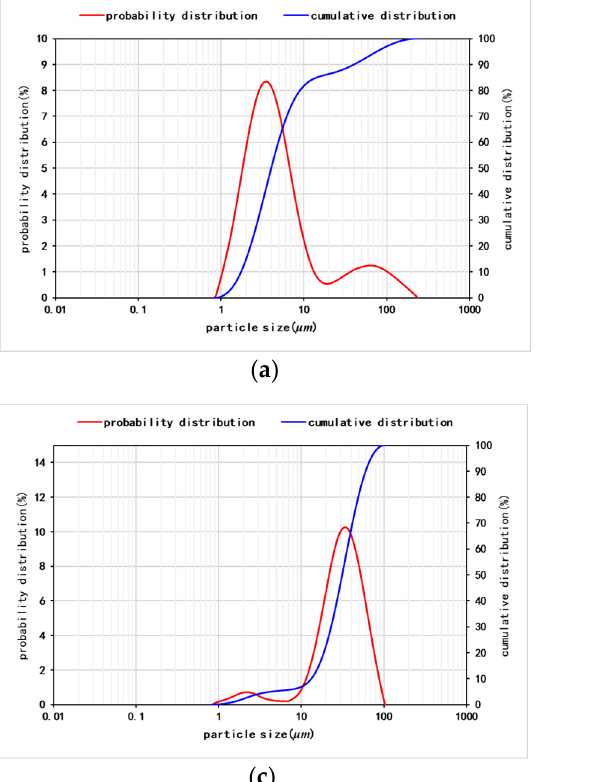
( d ) Figure 2. Emulsion phase behavior as a function of time at reservoir temperature. ( a ) Emulsion phase behavior as a function of time at reservoir temperature; ( b ) the microscopic images of the emulsion at 1 h; ( c ) the microscopic images of the emulsion at 10 h; ( d ) the microscopic images of the emulsion at 24 h. 3.1.2. Microsphere Performance Test